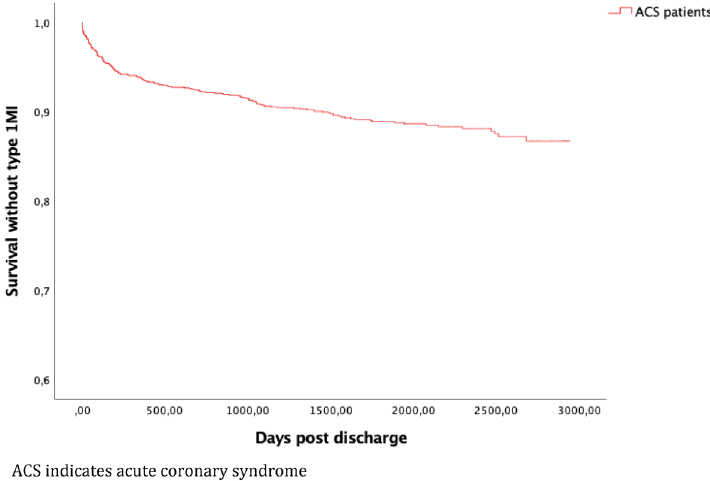
Figure 4. Cumulative Kaplan–Meier estimate of survival without type 1 myocardial infarction among 1379 patients discharged after hospitalization for ACS between 1 Jan 2010 and 31 Dec 2014.